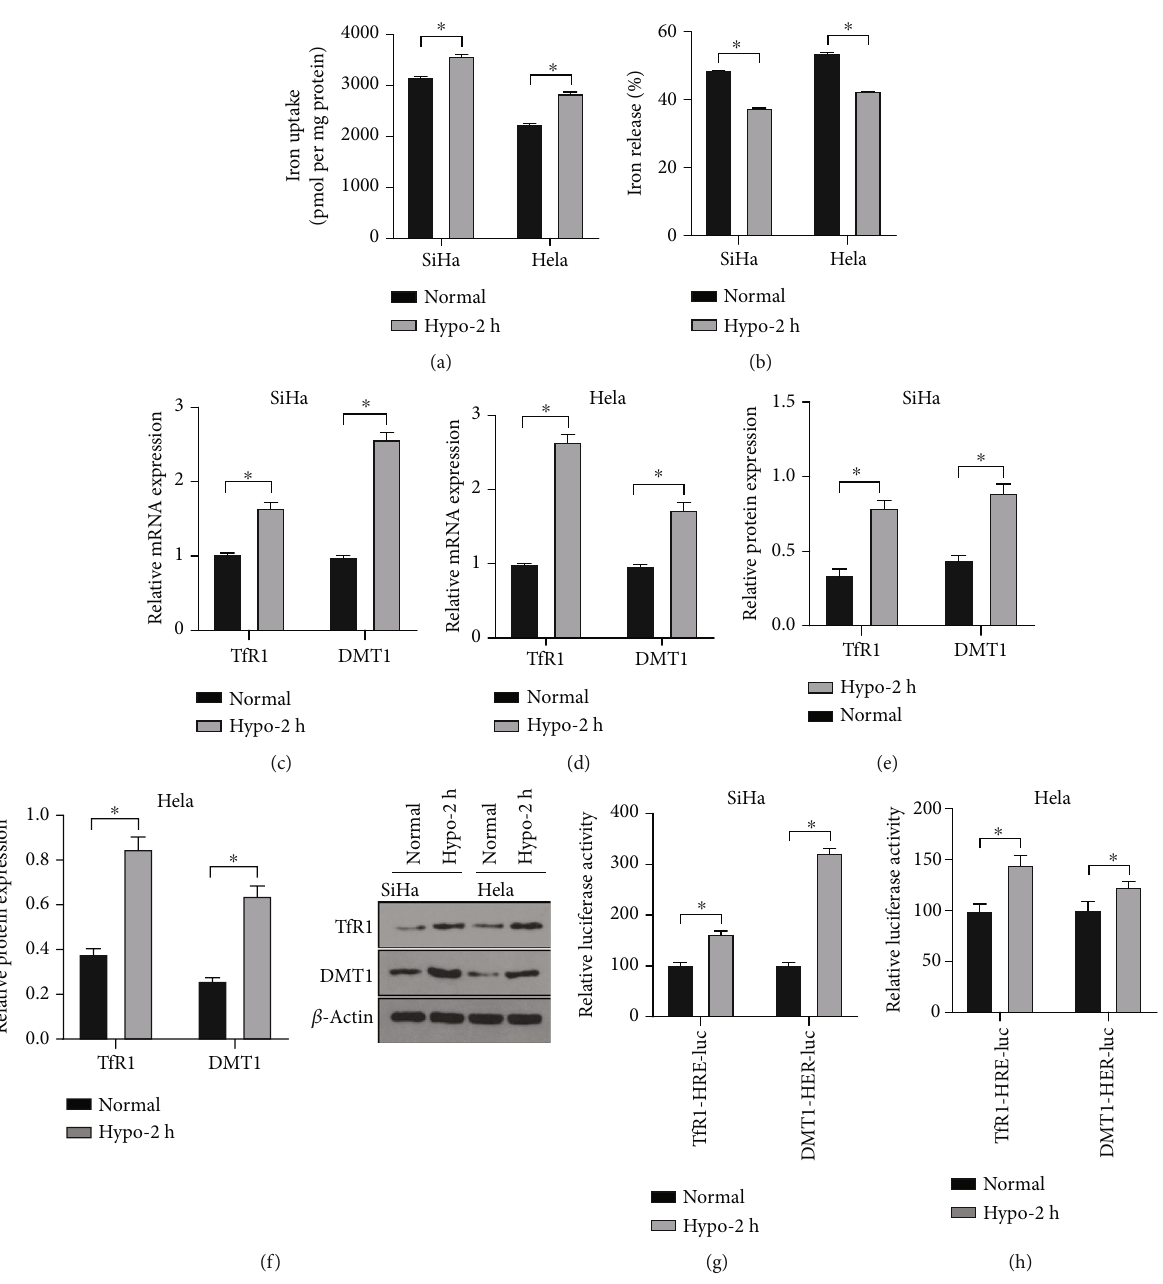
Figure 6: Hypoxia activated the HIF1/HRE pathway and upregulated expression of iron transporter in CC cells. SiHa and Hela cell lines were treated with hypoxia for 2 h. (A-B) Cell iron uptake and release were determined using isotope 55 Fe tracing method; (C-D) The mRNA levels of TfR1 and DMT1 in CC cells were detected by RT-qPCR; (E-F) The protein levels of TfR1 and DMT1 in CC cells were detected by Western blot; (G) The CC cells were transfected with di ff erent luciferase plasmids to detect luciferase activity. The experiments were conducted in 3 replicates independently. The data were expressed as mean ± standard deviation. The non-paired t test was utilized for comparisons among groups. ∗ p < 0 : 05